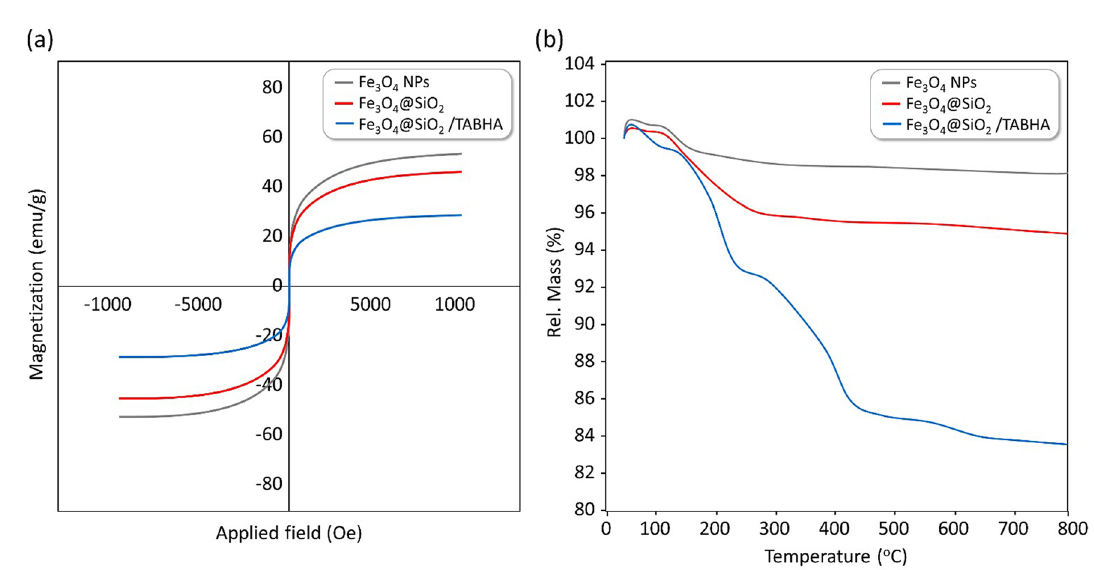
Figure 5. ( a ) VSM (room temperature), and ( b ) TGA (under air) curves of the neat Fe 3 O 4 , Fe 3 O 4 @SiO 2 , and